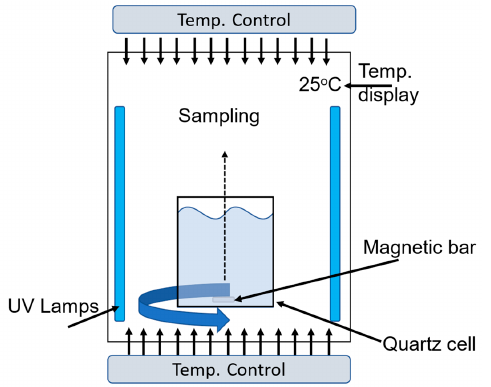
Figure 4. Experimental setup for the UV/heat activated PDS oxidation (adopted and modified from Sakulthaew et al. [59]. Table 2. Thermal activation of persulfate for degradation of ECs.